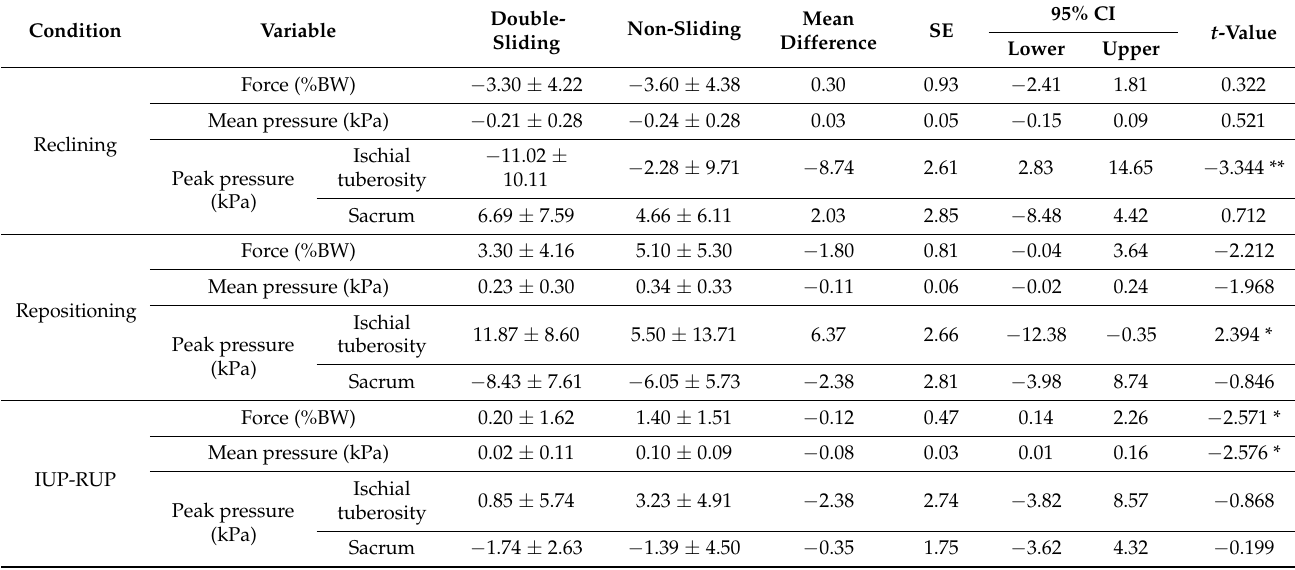
Table 4. Comparison of buttock pressure variation between the two conditions (double-sliding versus